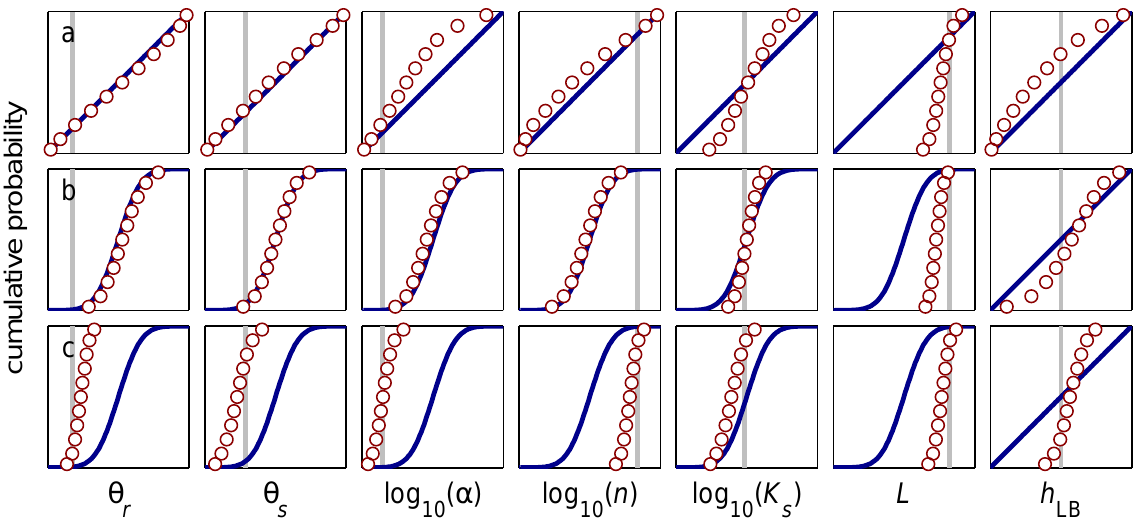
Fig. 4. Cumulative prior and posterior probability distributions using synthetic soil water content data and three different biased prior probability distributions: (a) multivariate uniform distribution (Prior 1), (b) multivariate normal distribution without correlation among the soil hydraulic parameters (Prior 2), and (c) multivariate normal distribution with correlation among the soil hydraulic parameters (Prior 3). The blue lines represent the prior distributions. The red circles denote the 2.5, 10, 20, 30, 40, 50, 60, 70, 80, 90, and 97.5% quantiles of the posterior distributions, respectively. The grey lines mark the parameter values used to generate the data. The x-axes cover the bounds listed in Table